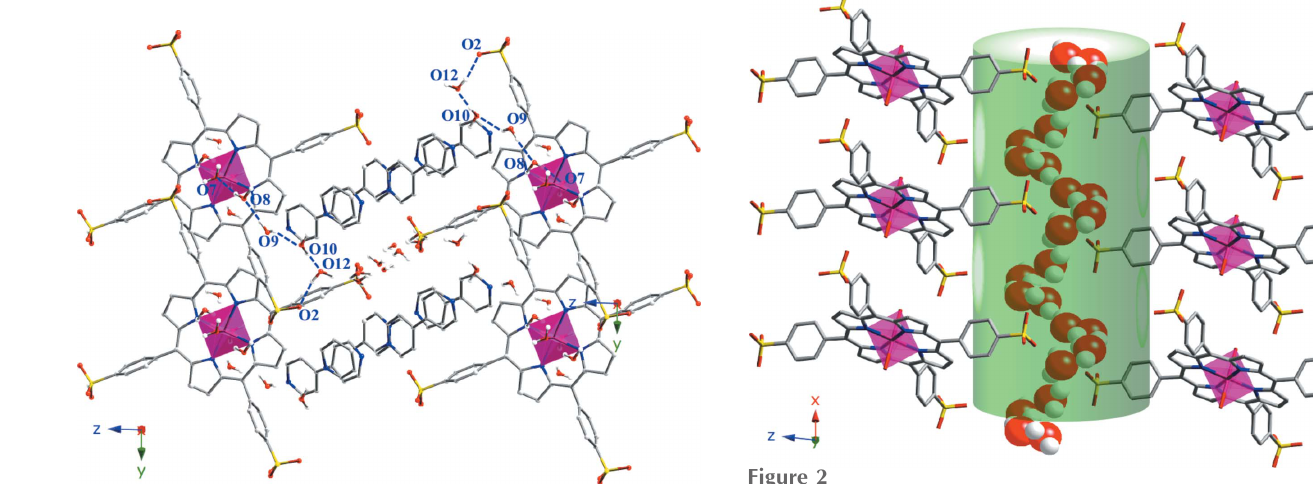
Figure 2 Representation of the accessibility of guest molecules to the active metal centres for compound 1 . Colour code: Mn pink, C grey, N blue, O red and S yellow. The accessible pathway is represented by the green